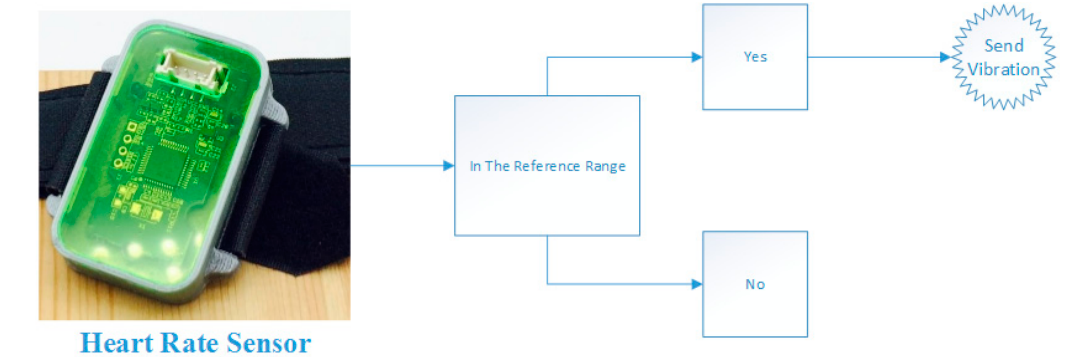
Figure 2. Sensor that detects heart rate changes.